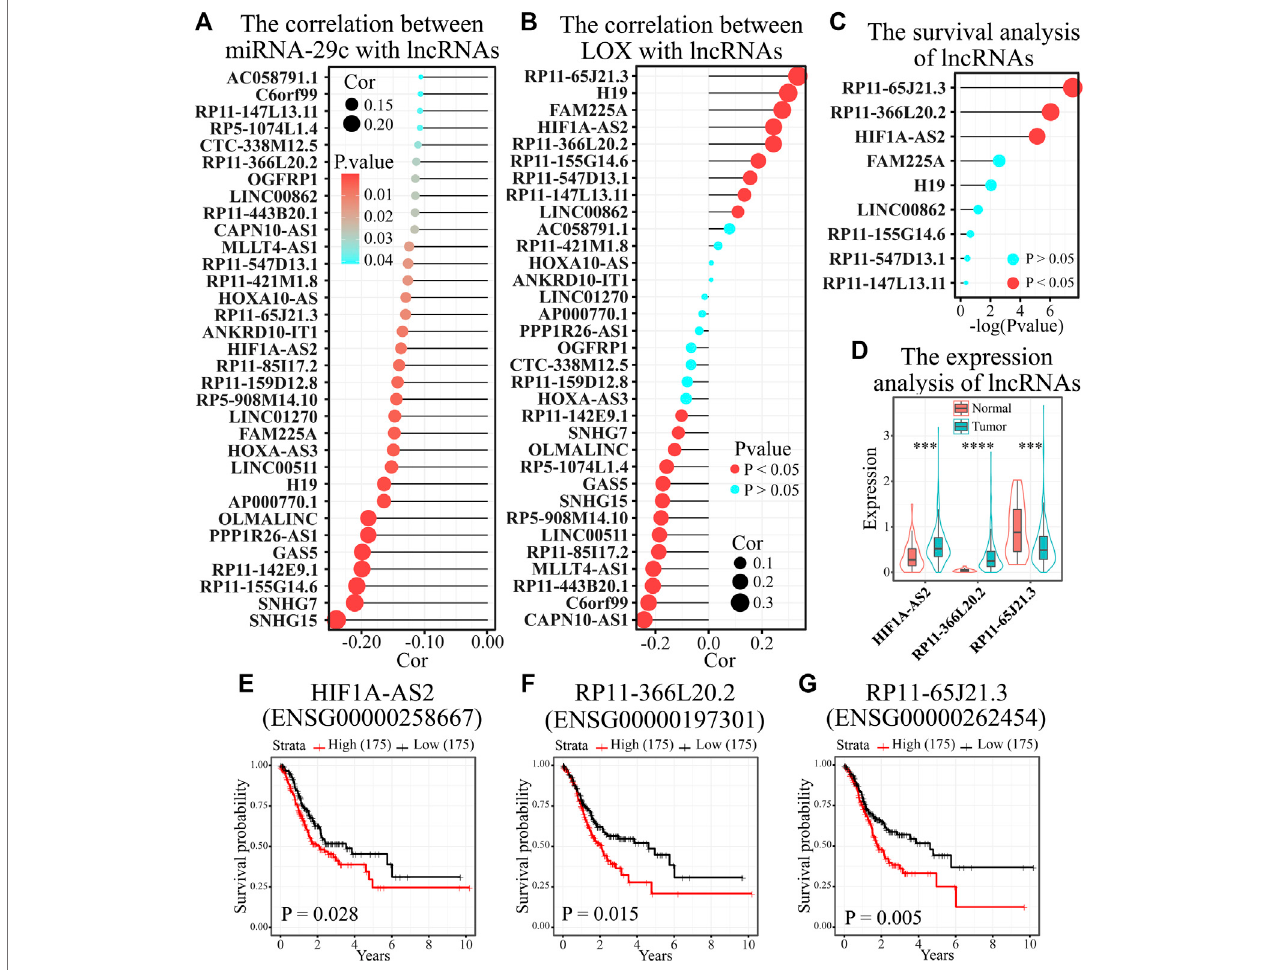
FIGURE 4 | HIF1A-AS2 and RP11-366L20.2 were considered as the most possible upstream regulatory lncRNAs of the miRNA-29c/LOX axis in gastric cancer. (A) Thirty-three of 298 potential upstream lncRNA candidates were negatively correlated with miRNA-29c in gastric cancer. (B) The relevance analysis between 33 lncRNAs and LOX in 372 STAD samples. (C) The survival analysis of nine lncRNAs positively correlated with LOX in gastric cancer. (D) The expression analysis of nine lncRNAs in 375 STAD samples and 32 non-cancer samples. (E – G) The survival curves of HIF1A-AS2 (E) , RP11-366L20.2 (F) , and RP11-65J21.3 (G) in gastric cancer. *** p < 0.001 and **** p <